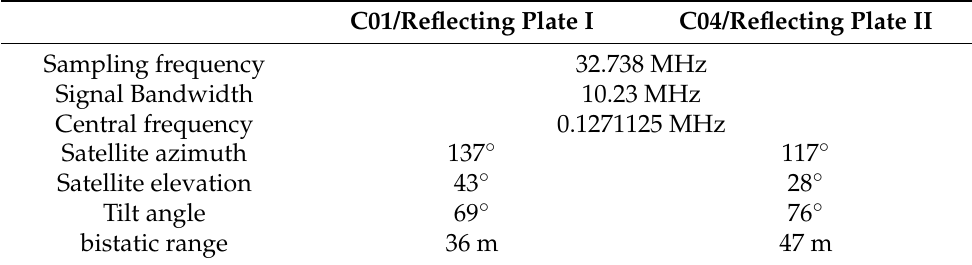
Figure 6. Experimental scenario photographed by drone. Table 1. Experimental system